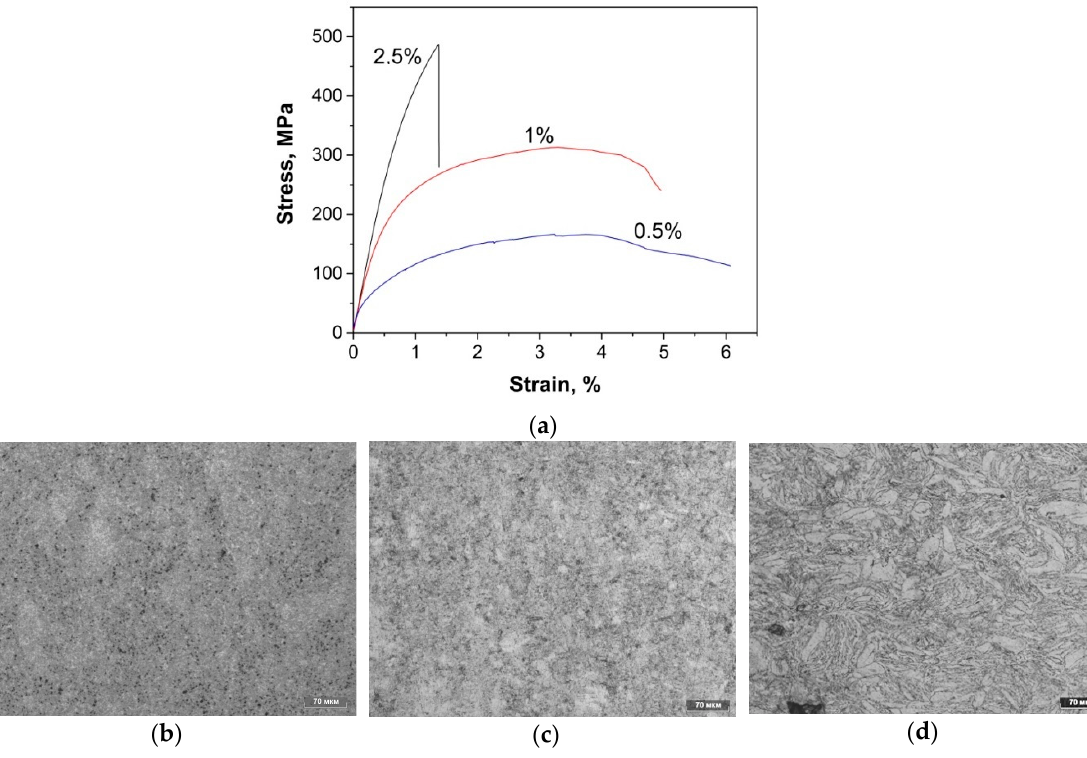
Figure 10. The results of three point flex test of Al-CNFs composites ( a ) and optical micrographs of the polished cross sections of ( b ) 2.5 wt.%, ( c ) 1 wt.%, and ( d ) 0.5 wt.% Al–CNFs composites.